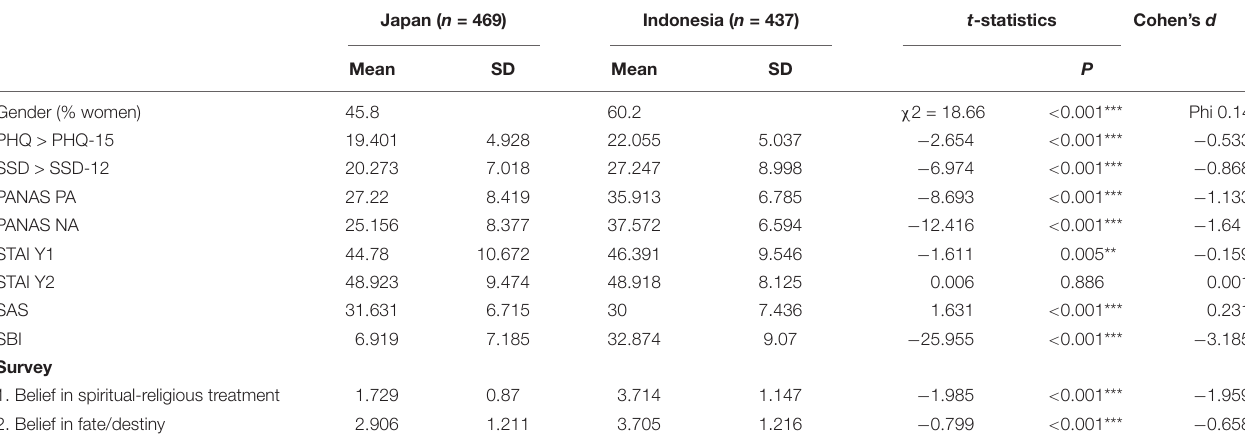
TABLE 1 | Descriptive statistics of gender, somatic symptom, affective state, subjective body perception, and spiritual belief in Japanese and Indonesian